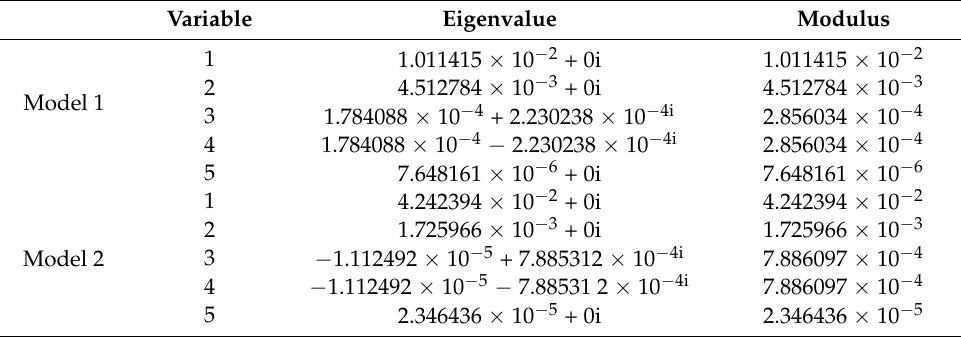
Table 4. Eigenvalue stability condition of